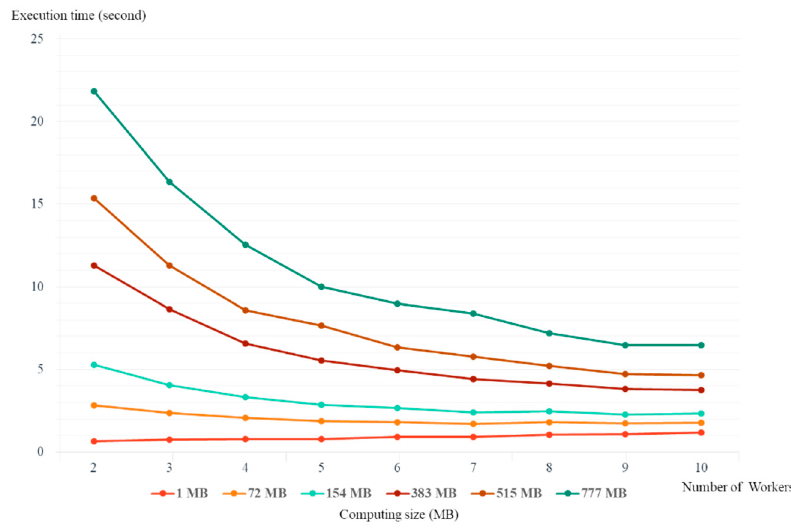
Figure 10. Comparison of execution time as the number of workers increases.